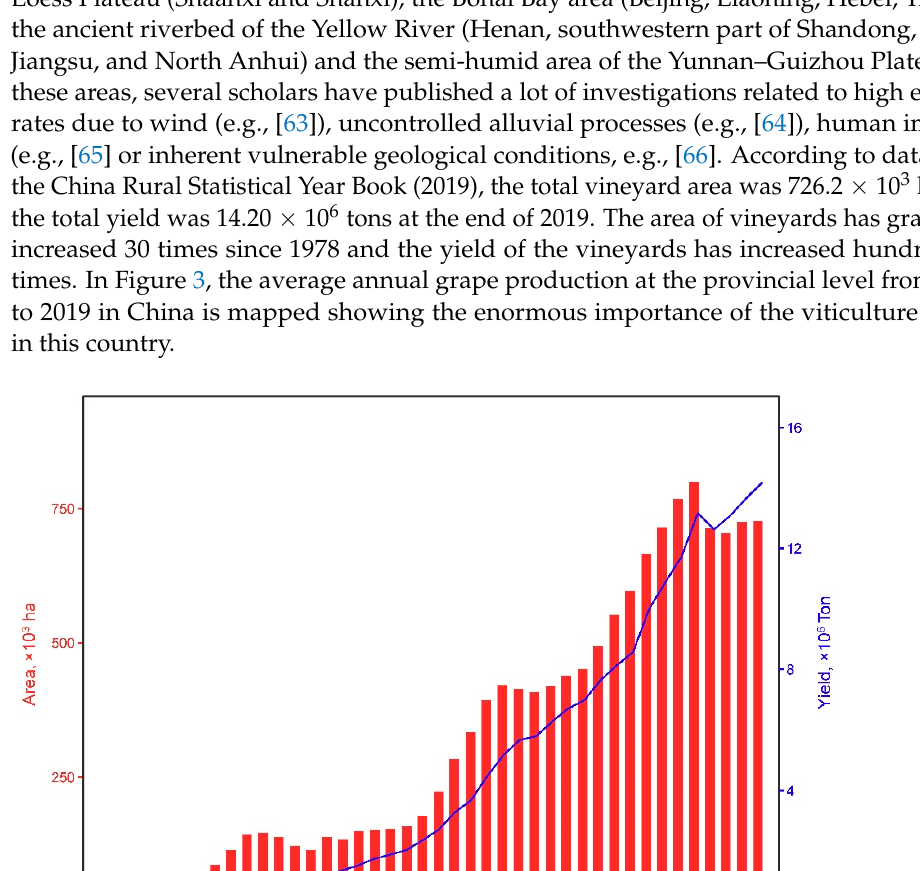
Figure 3. Vineyard area and yield changes from 1978 to 2019 (data from the China Rural Statistical Year Book, 1985–2019, China Year Book, 1985–2019, China Statistics).